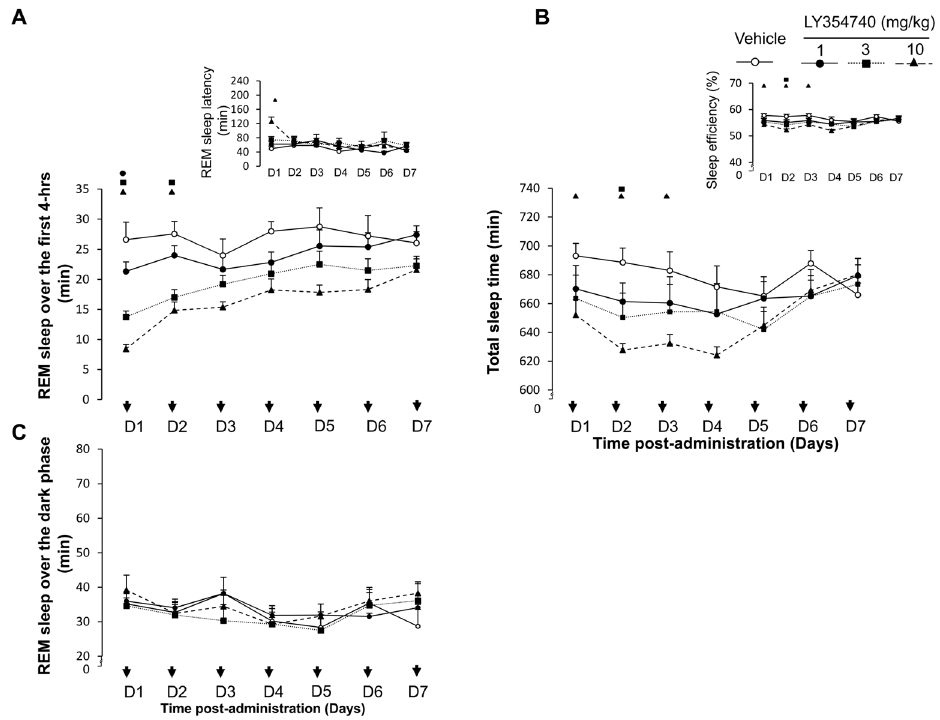
Fig 4. Sleep parameters following repeated dosing with LY354740 (1, 3, 10 mg/kg) or vehicle on experimental days (D1 first treatment day till D7 seventh treatment day). Total sleep time expressed in minutes (Panel A) and sleep efficiency expressed in percentage (Panel A inset). REM sleep amount during the first 4-h of recording sessions after repeated administration (Panel B) and REM sleep latency (Panel B inset). Total amount of REM sleep expressed in minutes that was recovered during the subsequent 10-h dark period (Panel C). The data are presented as means ± S.E.M. Significant differences between the vehicle and LY354740 group are indicated by the drug-dose